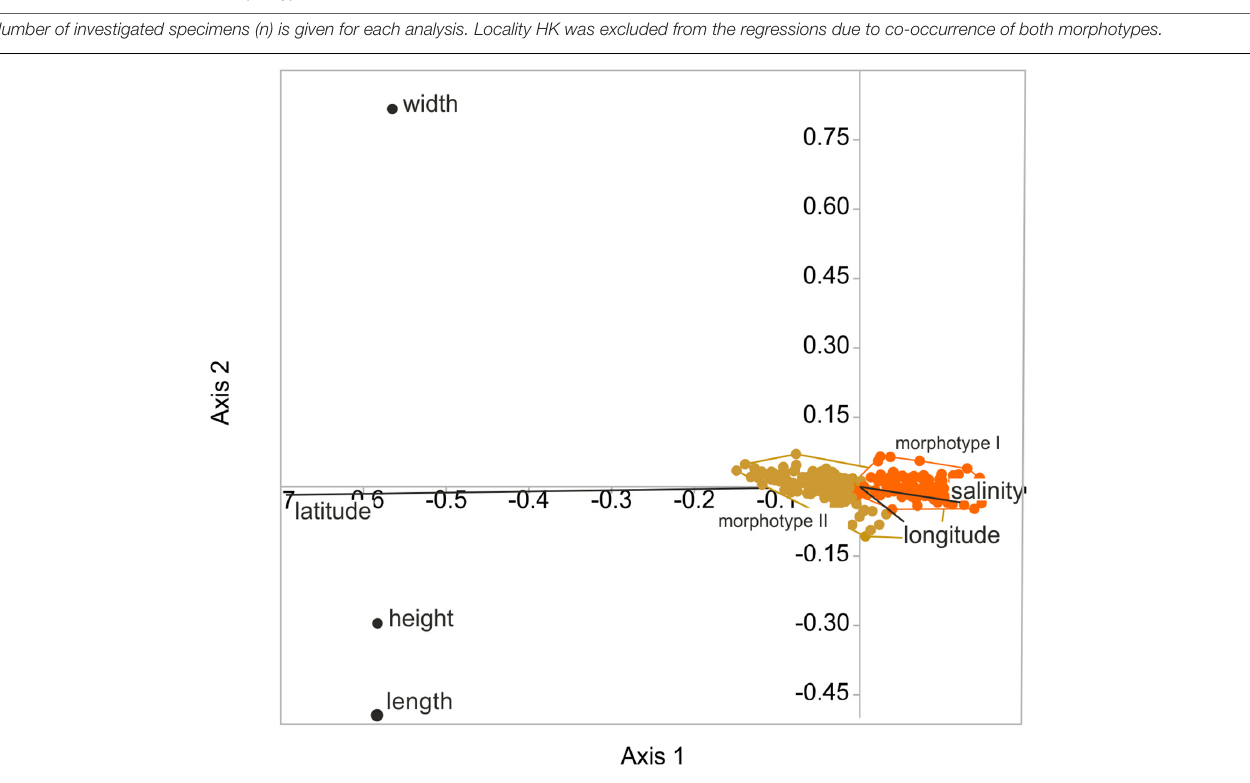
FIGURE 6 | Results of the redundancy analysis (RDA) of valve size (length, height, width) and geographical area (latitude, longitude) displayed for female left valves differentiated for size morphotypes (orange = morphotype I, gold = morphotype II; adjusted r 2 =